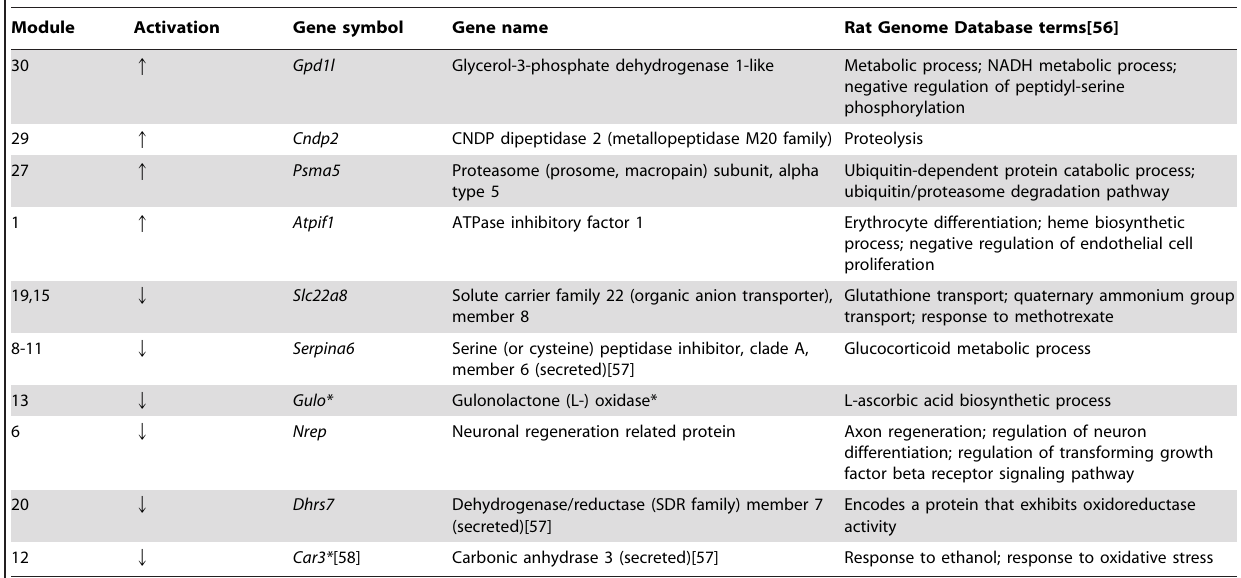
Table 4. Gene signatures for Periportal lipid accumulation .